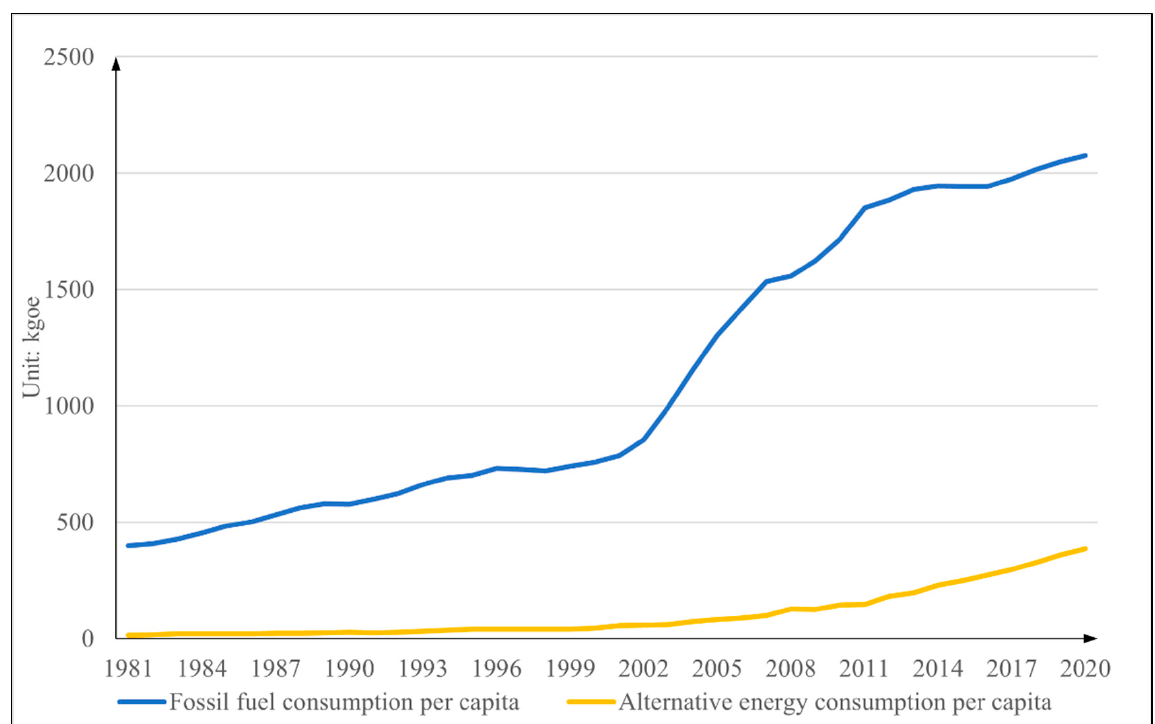
Figure 2. Trend of per capita fossil fuel and alternative energy consumption from 1981 to 2020 in China.